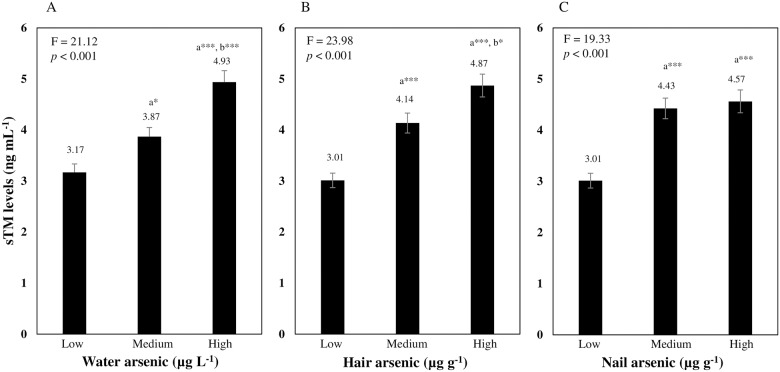
Dose-response relationship between arsenic exposure and sTM levels.Data were presented as mean ± SE. Dose-response relationship between arsenic exposure and sTM levels in one-way ANOVA was examined by F-test, followed by Bonferroni multiple comparison test between each group of exposure level. Arsenic concentrations in water: low (0.03–5.22 μg L-1; n = 101), medium (5.30–127.00 μg L-1; n = 110), and high (129.00–546.00 μg L-1; n = 110). Arsenic concentration in hair: low (0.02–0.62 μg g-1; n = 106), medium (0.64–3.36 μg g-1; n = 106), and high (3.40–37.24 μg g-1; n = 109). Arsenic concentrations in nail: low (0.15–2.12 μg g-1; n = 104), medium (2.14–7.45 μg g-1; n = 109), and high (7.45–37.42 μg g-1; n = 108). a and b, Significant from low and medium groups, respectively. ***p < 0.001; **p < 0.01; *p < 0.05.